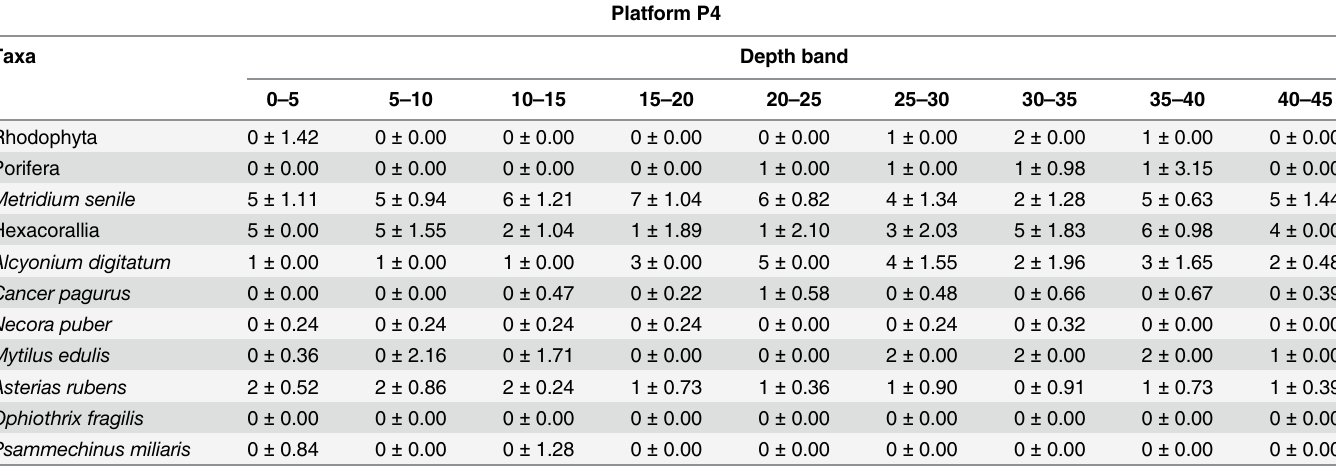
Table 7. Averaged categorised abundance of the 11 high detectable taxa, with 95% confidence interval around the mean, per depth band on plat- form